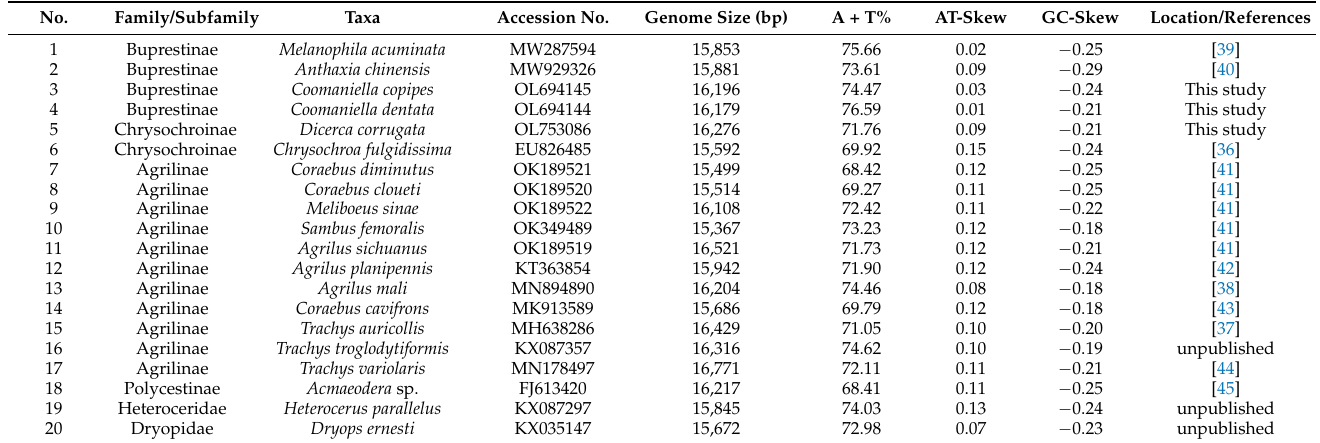
Table 1. Taxonomy, GenBank accession numbers, and related information on the mitochondrial genomes used for the phylogenetic